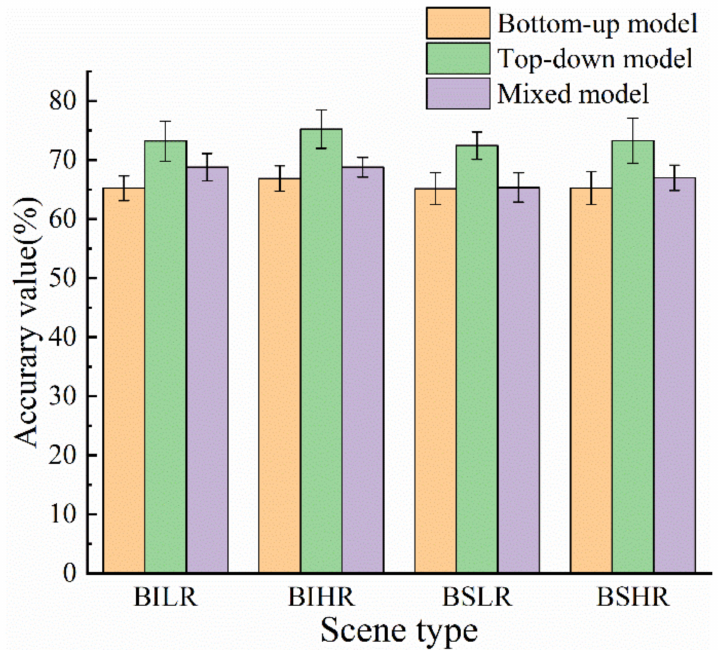
Figure 7. Statistics on the accuracy of model validation in four different scenes. Bars and error bars represent mean values and standard deviations, respectively. (BILR is building intensive low-rise area. BIHR is building intensive high-rise area. BSLR is building sparse low-rise area. BSHR is building sparse high-rise